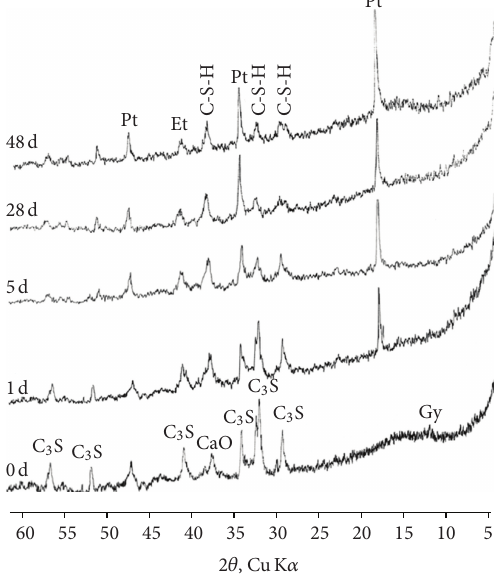
F 2: Powder XRD patterns of cement paste PC1 at different ages of hydration.